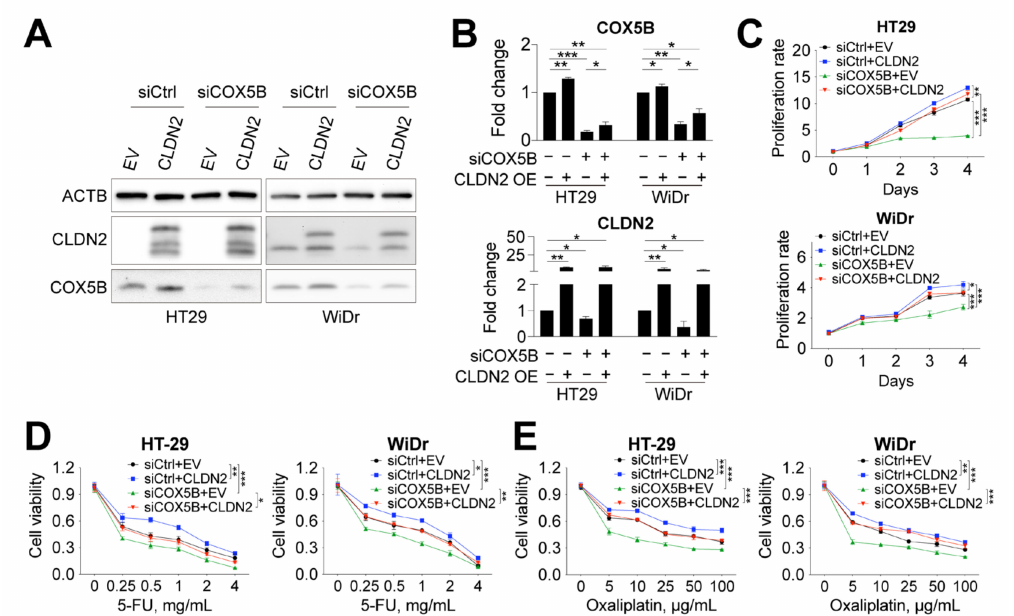
Figure 6. CLDN2 works downstream of COX5B-induced bioenergetic alterations in orchestration of cell growth and susceptibility to anticancer drugs in CRCs cells. ( A ) The representative images of Western blot analysis of lysates with indicated treatments. ( B ) The quantitative analysis and comparisons of protein levels of either COX5B and CLDN2 under indicated treatments. − , cells without indicated treatment; +, cells with indicated treatment. ( C ) The cell renewal capability was determined with or without COX5B silencing and CLDN2 overexpression in CRCs cells. The sensitivity of cells in response to the anticancer drugs, ( D ) 5-FU and ( E ) Oxaliplatin, was examined by cell viability assay. *, p < 0.05; **, p < 0.01; ***, p < 0.001. The p values in ( B ) were acquired by two-tailed paired Student’s t -test while in ( C – E ) were obtained by two-way ANOVA with correction by Bonferroni